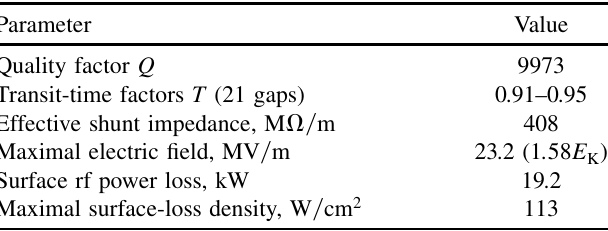
TABLE VI. EM Parameters of IH1m